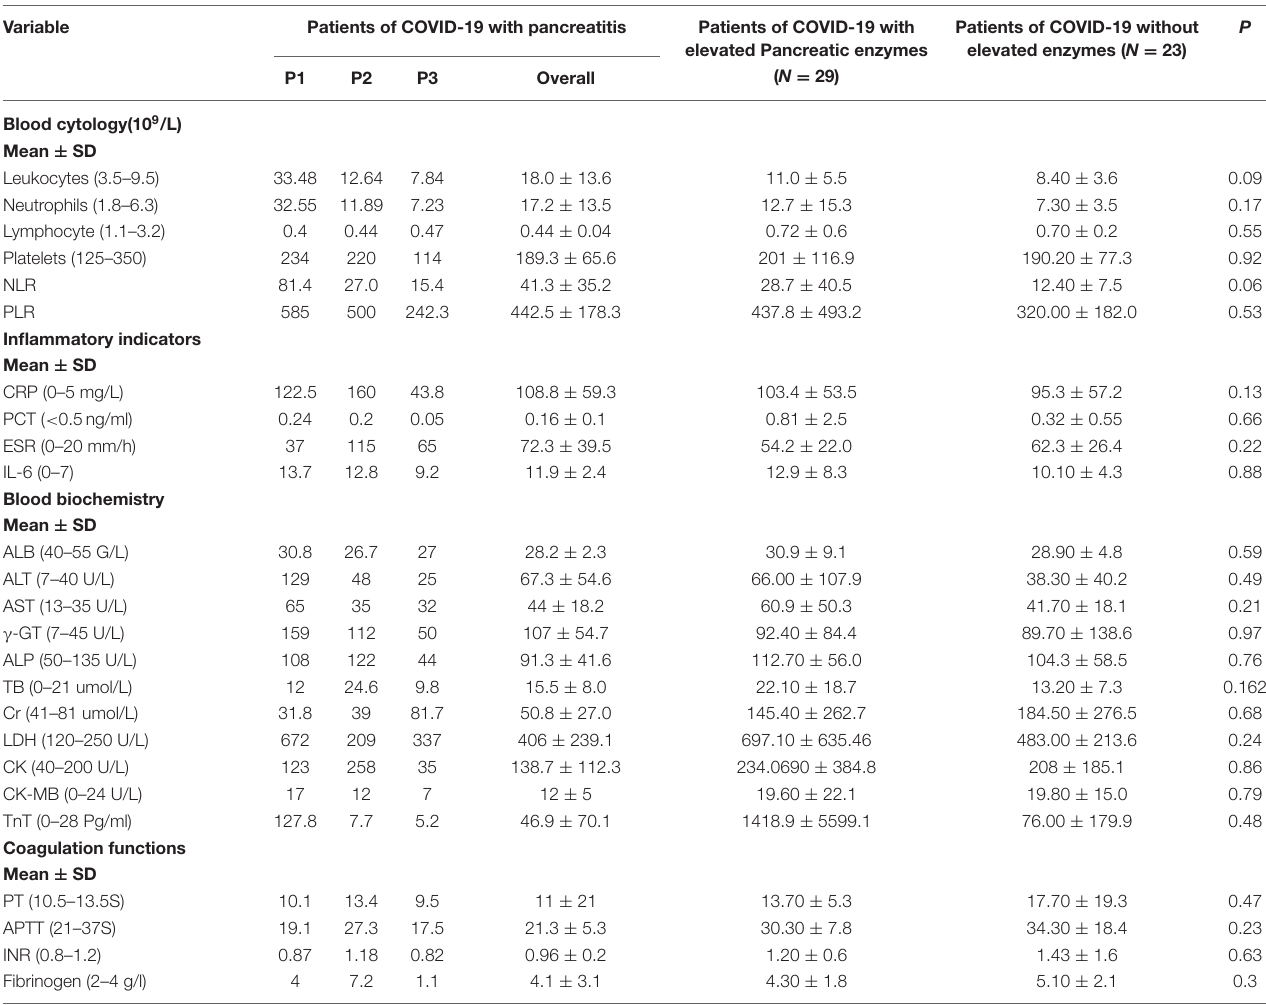
TABLE 3 | Laboratory results of patients with COVID-19. Variable Patients of COVID-19 with pancreatitis Patients of COVID-19 with